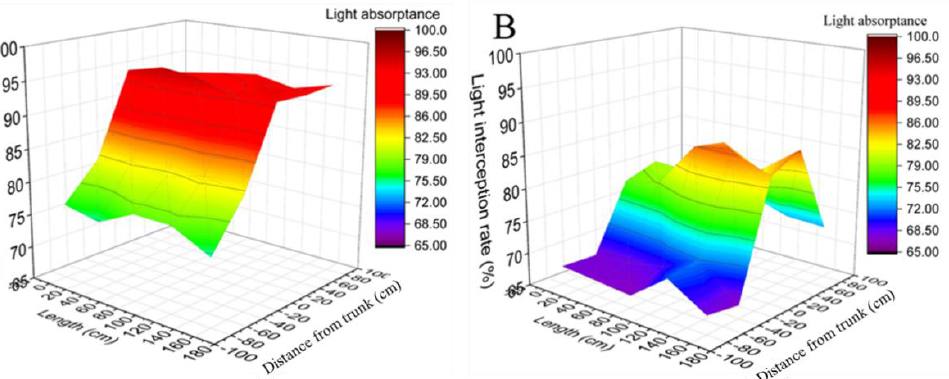
Figure 4. Light interception rates of SCT (single-curtain training system) ( A ) and PER (pergola) and SCT ( B ) at veraison. Data are means ± SD of three independent replicates. Different letters indicate a significant difference at p < 0.05 as determined by Duncan’s multiple range